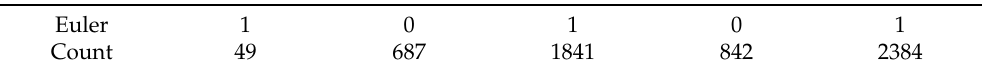
Table 10. First, second and third decomposition type (from left to right)—distributions of combinato- rial Euler characteristics of segment complexes from border interior overlay.